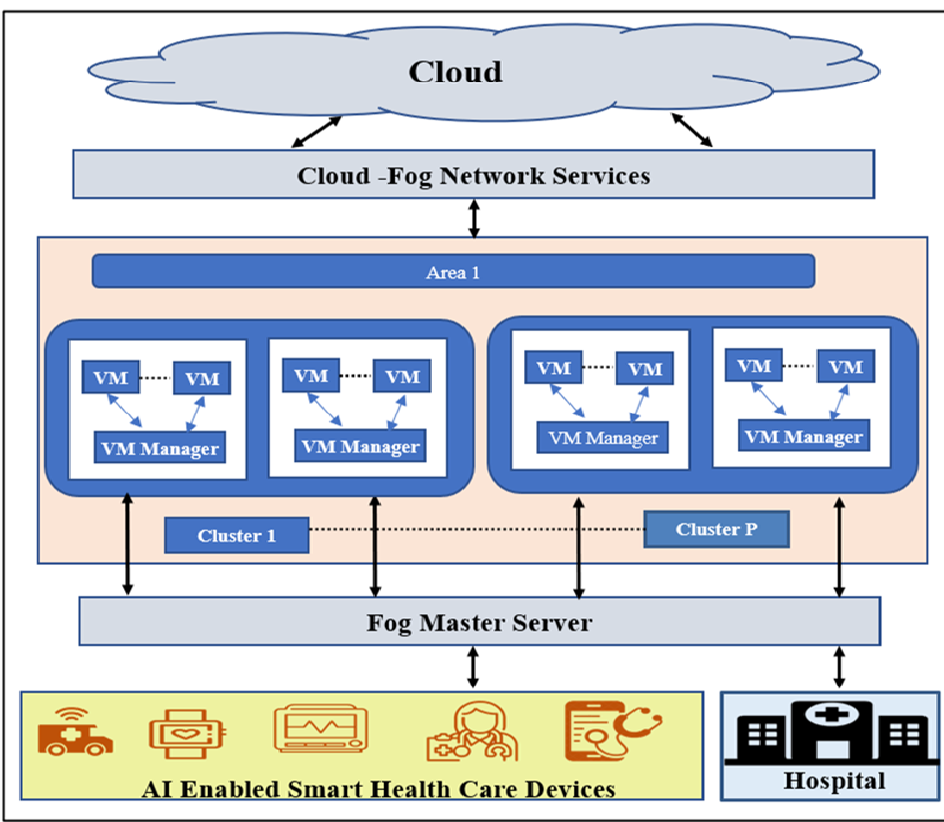
Figure 6. Framework for fog-enabled communication in healthcare .